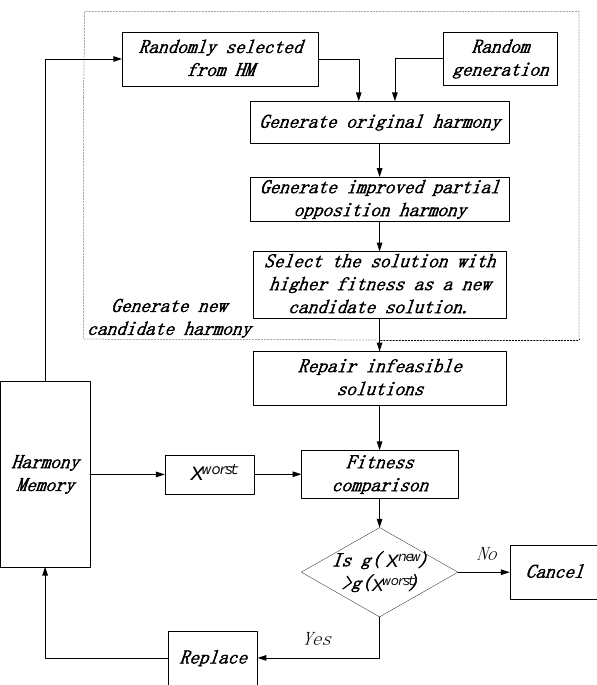
Fig. 3 Harmony search based on improved partial opposition-based learning.